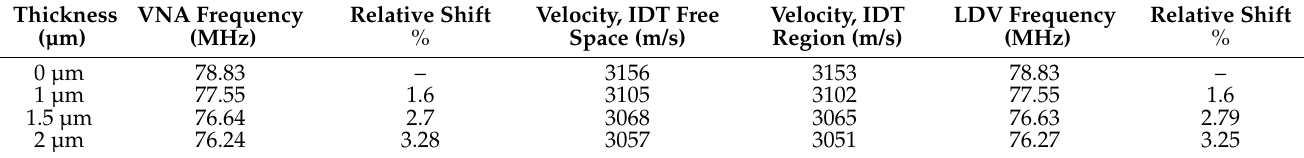
Table 3. VNA measurements of central frequency shift (first and second columns), the results of optical sound velocity measurements (third and fourth columns) and a comparison of the two measurement methods in terms of frequency (fifth and sixth columns, λ 0 = 40